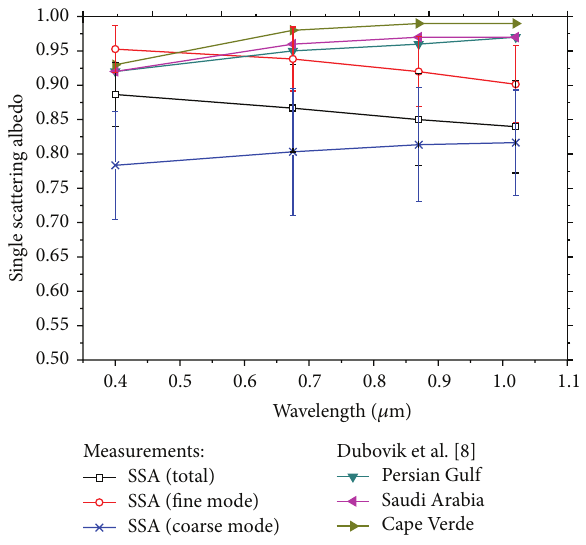
Figure 10: The total SSA, SSA of fine mode, SSA of coarse mode of dust aerosol at 0.44, 0.67, 0.87, and 1.02 𝜇 m and measurements from Dubovik et al. [10]